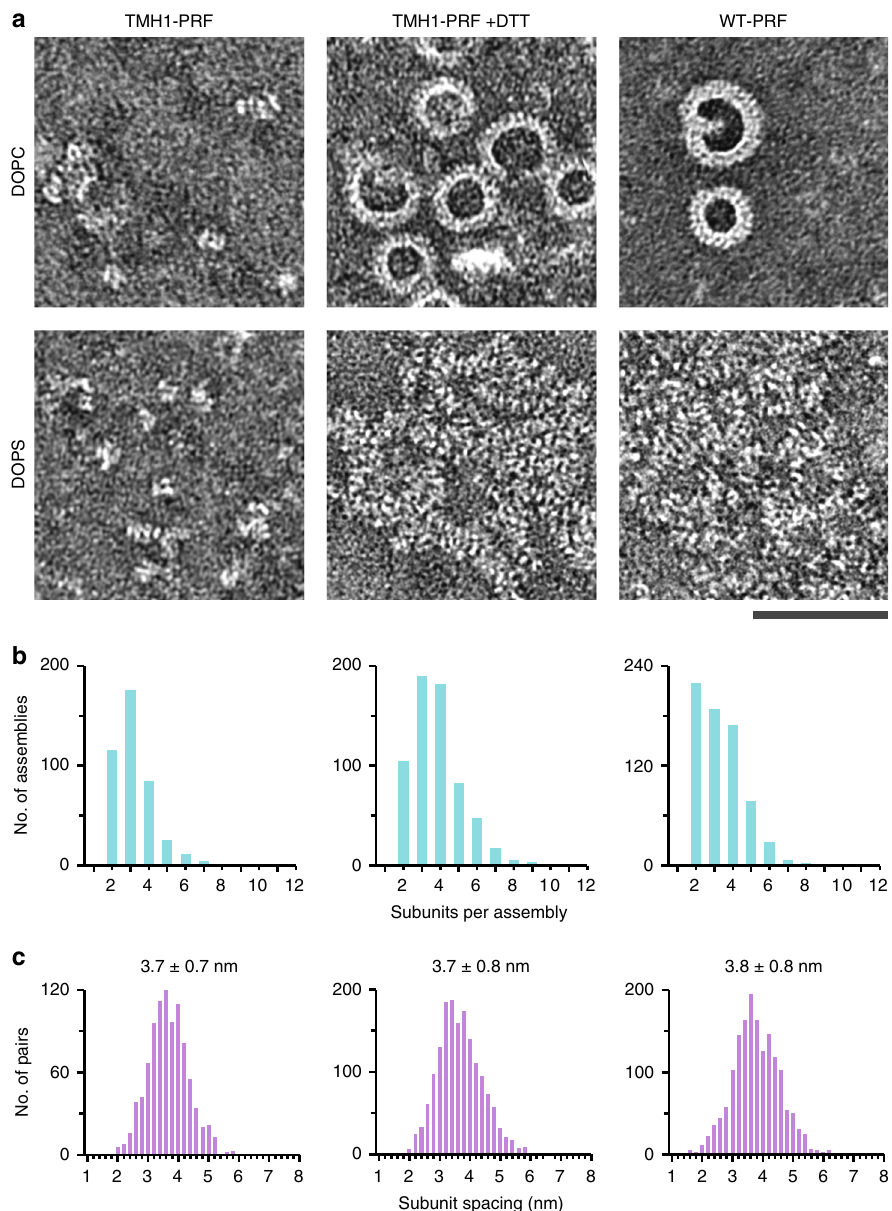
Fig. 6 On DOPS, perforin assemblies retain properties found in prepores. a EM images of DOPC and DOPS monolayers after incubation with TMH1- PRF ( – DTT), unlocked TMH1-PRF + DTT, or with WT-PRF, at subunit resolution. On DOPC, TMH1-PRF prepores are visible as short, loose assemblies, which grow into arc- and ring-shaped pores after unlocking (TMH1-PRF + DTT) or when using WT-PRF, accompanied by a tighter subunit packing, and fully consistent with previous observations 6 . On DOPS, initially short assemblies formed by TMH1-PRF appear similar to prepores formed on DOPC. After unlocking with DTT or when incubating with WT-PRF, the clusters retain signatures of short assemblies, and lack the tight packing observed for perforin pores. Scale bar, 50 nm. b Length distributions of assemblies as found in isolated assemblies and clusters on DOPS that show subunit repetitions (see Methods). c Average subunit spacing (± standard deviation) on DOPS; these results are comparable with previously published data on perforin prepore (TMH1-PRF) assemblies formed on PC-rich membranes, with sizes ranging between 2 and 10 subunits and a subunit spacing of 3.86 ± 0.13 nm; on such PC rich membranes, pore assemblies are signi fi cantly larger and have a tighter subunit spacing, 2.55 ± 0.09 nm 6 . Source data for b and c are provided as a Source Data fi Here, we have demonstrated that some physiologically rele- vant types of lipid membrane composition are far less suscep- tible to perforin binding and/or poration than others; and that CTLs use these more resistant lipid formulations in a two- layered self-defence mechanism to maximize protection. In particular, the lymphocytes become refractory to secreted killer proteins due to increased plasma membrane lipid order, thus reducing perforin binding, and the exposure of negative charge